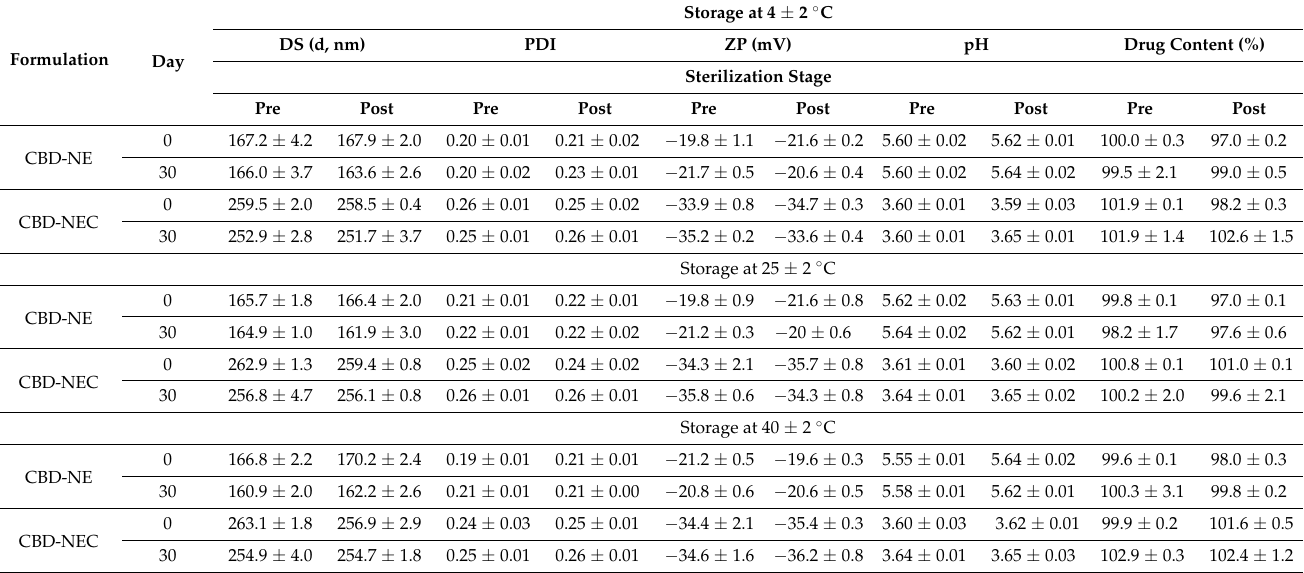
Table 3. Stability data for CBD-NE and CBD-NEC nanoemulsion formulations pre- and post- steril- ization over one month of storage at 4, 25, and 40 ◦ C (mean ± SD, n =